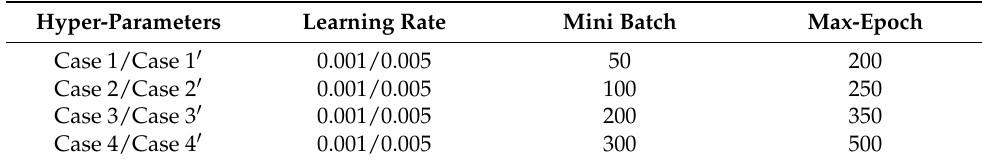
Table 3. Hyper-parameters list for the proposed model.